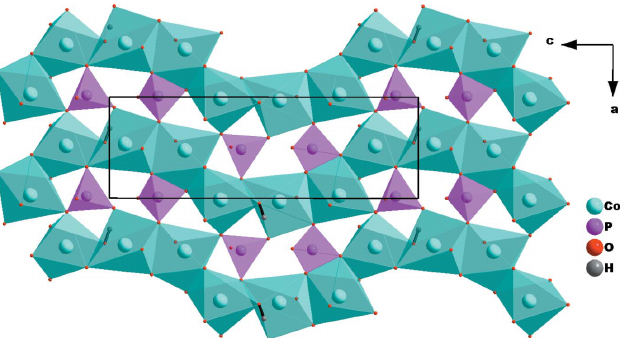
Figure 3 Edge-sharing [CoO 6 ] octahedra and PO 4 tetrahedra building a layer parallel to (010).